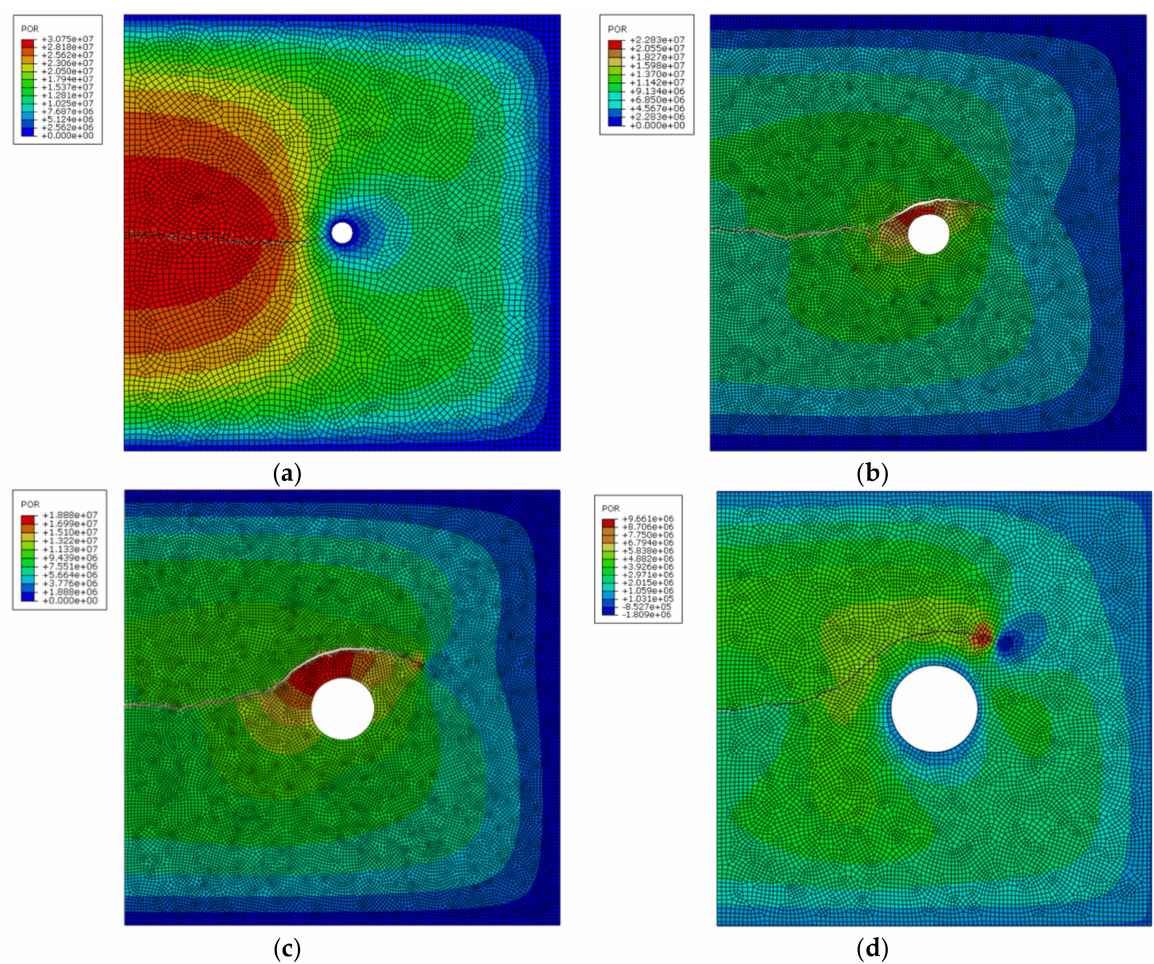
Figure 13. Cloud diagram of fracture propagation under different vug size: ( a ) R = 1 m; ( b ) R = 2 m; ( c ) R = 3 m; and ( d ) R = 4 m. (POR is the pore pressure. With the color gradually changing from red to blue, the pore pressure